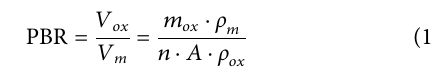
Frontiers in Bioengineering and Biotechnology |